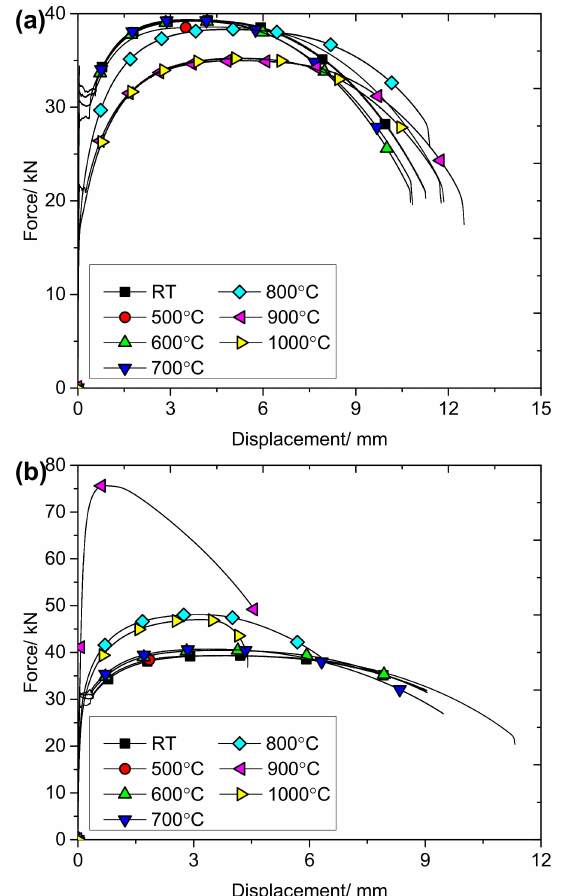
Figure 2. Load displacement curves of the SPR specimens, ( a ) air-cooled, and ( b )